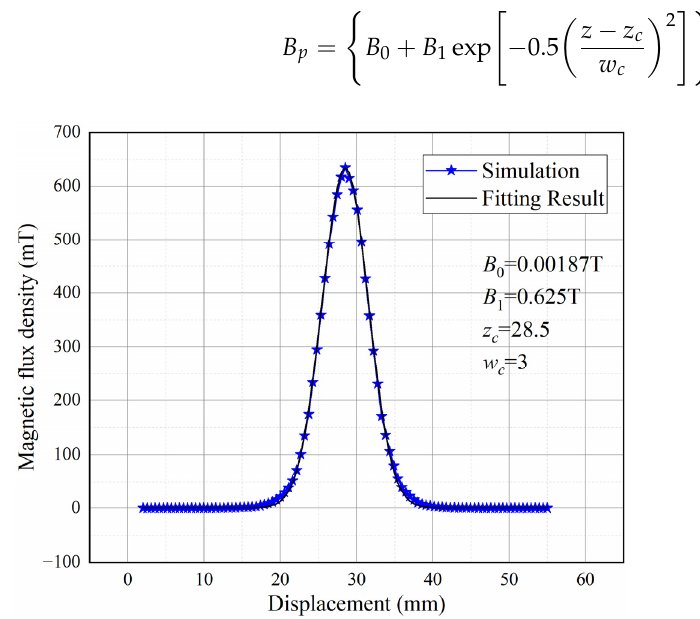
Figure 3. Magnetic flux density in the axial direction.